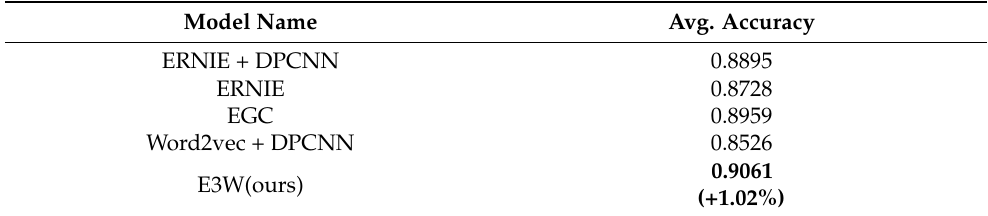
Table 6. Comparison of average accuracy for E3W and the four sub-models, with the best experimen- tal results in bold and the number in brackets representing the comparison of the current model with the previous best model.